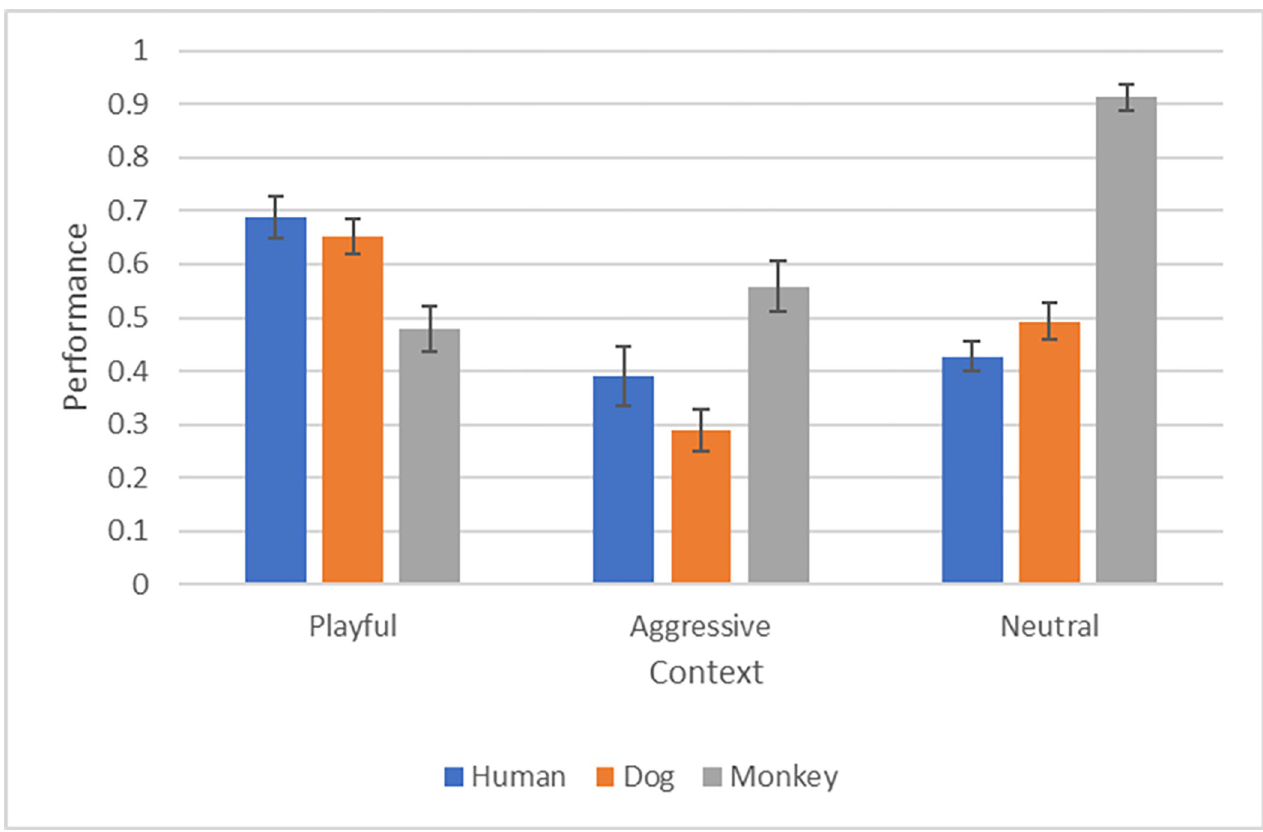
Fig 1. Depicts the average correct responses for the context identifications for each species and context in group 1. Participants performed similarly at predicting the outcome and categorizing the context (main effect of type of task: F(1, 90) = 8.70e-4, p = 0.977; η 2 = 9.67e-6). However, there was a significant 3-way interaction of species, context and type of task (F(4,360) = 11.160, p < .001; η 2 = 0.110), indicating that the performance of participants in the two groups differed depend- ing on species and outcome. Furthermore, there was a significant interaction between species and type of task, indicating that participants in the two groups showed performed differently depending on the species (F(2, 180) = 21.40, p < .001; η 2 = 0.192). However, context did not impact participants’ performance, as there was no significant interaction between type of task and context (F(2,180) = 0.943, p = 0.392; η 2 = 0.110). Moreover, we found a significant interac- tion between species and context (F(4,360) = 29.40, p < .001; η 2 = 0.246), demonstrating that participants performed differently for the three species and this effect depended on the con- text. Finally, performance was different for the three species (main effect of species: F(2,180) = 17.44, p < .001; η 2 = 0.162), with all participants performing better with primates than dogs. Performance was also different for the three main contexts (main effect of context: F(2,180) = 66.51, p < .001; η 2 = 0.425). two types of task (tested in the groups) separately. Then we present the relevant comparisons between groups.